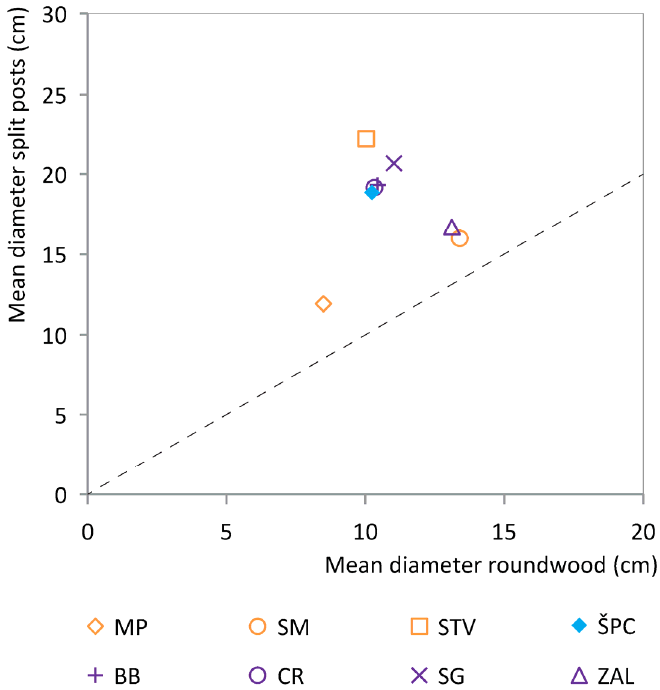
Figure 5. Scatterplot showing the mean diameter of split oak posts in relation to the mean diameter of unsplit oak posts. Each data point represents a site (see Table 1 for the explanation of the site name abbreviations). The dataset includes all sites with >50 posts with diameter data and with substantial numbers of both split and unsplit posts.